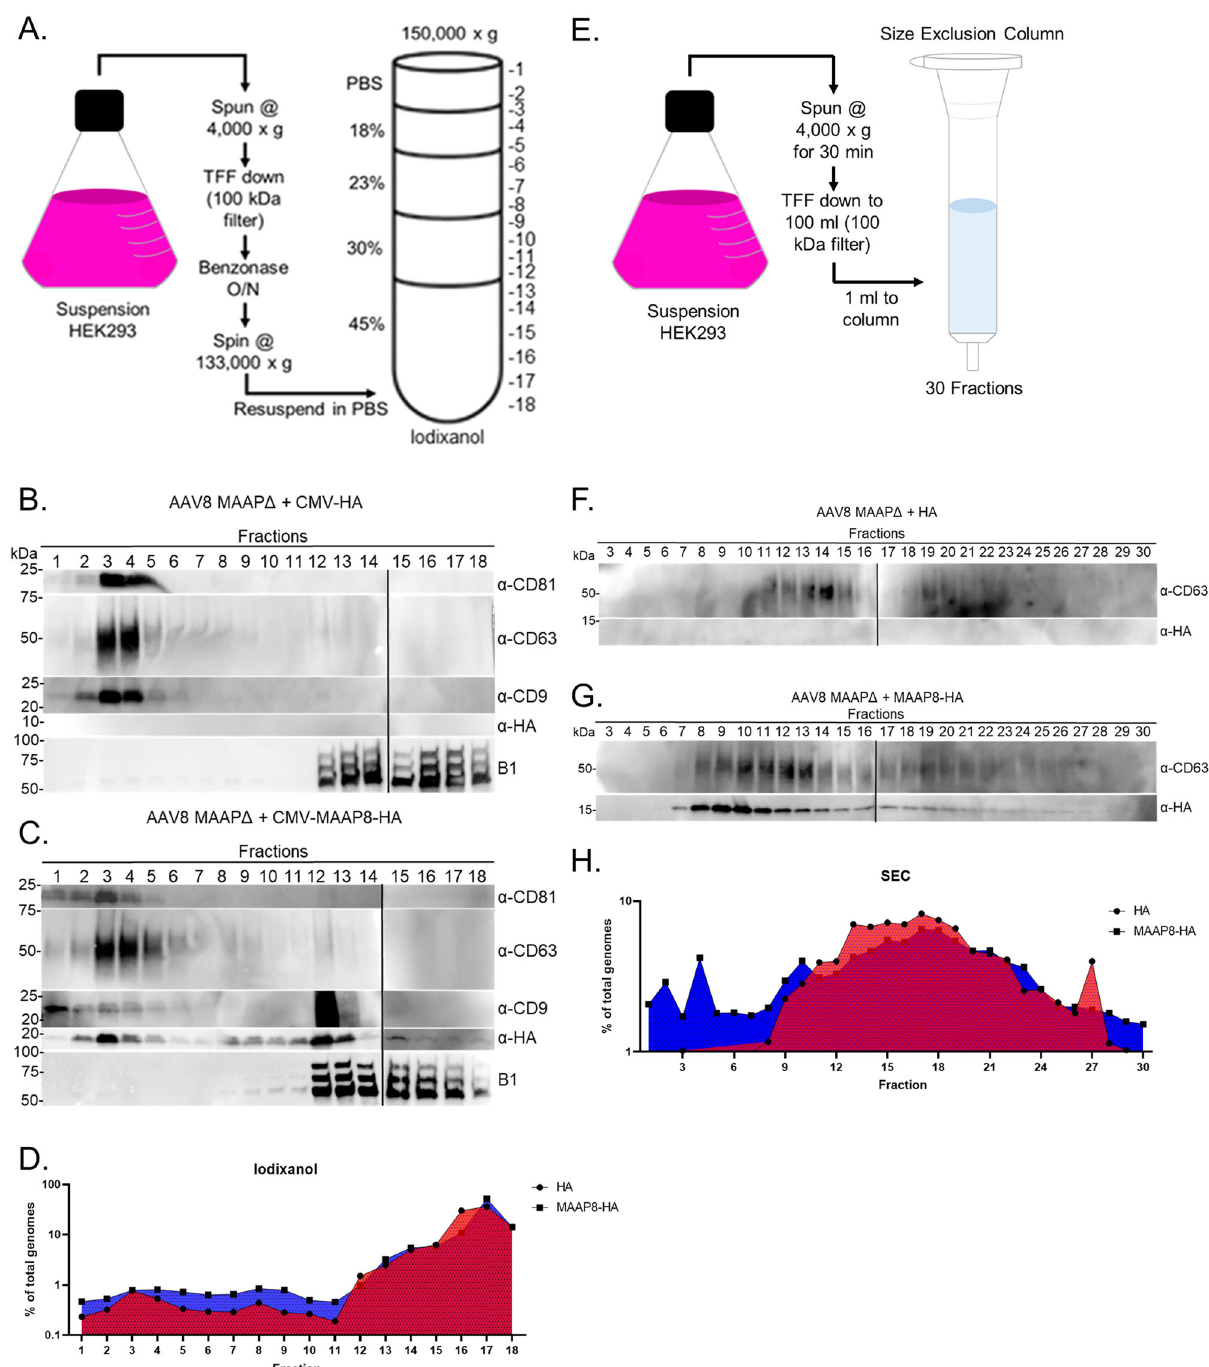
Fig. 5 MAAP promotes association of AAV with EVs. A Schematic of EV isolation by iodixanol density gradient from HEK293 suspension culture. B Immunoblots of iodixanol fractions from suspension cells producing recombinant MAAP8 Δ vector complemented in trans with CMV-HA and C CMV- MAAP8-HA. EVs, capsid and MAAP were analyzed from the media of HEK293 producing cells at day 3 post transfection. Capsid and MAAP proteins were analyzed by SDS-PAGE under reducing conditions while EV markers (CD81, CD63, CD9) were analyzed by SDS-PAGE under non-reducing conditions ( n = 2). D Graph displaying percent vector genome titer relative to total viral genomes for each fraction from iodixanol gradient puri fi ed MAAP8 Δ vector complemented in trans with CMV-HA and CMV-MAAP8-HA. E Schematic of EV isolation by size exclusion chromatography (SEC) from HEK293 suspension culture. F Immunoblots of SEC fractions from suspension cells producing recombinant MAAP8 Δ vector complemented in trans with CMV-HA and G CMV-MAAP8-HA. EVs and MAAP were analyzed from the media of HEK293 producing cells at day 3 post transfection. MAAP protein was analyzed by SDS-PAGE under reducing conditions while the EV marker CD63 was analyzed by SDS-PAGE under non-reducing conditions ( n = 2). H Graph displaying percent vector genome titer relative to total viral genomes for each fraction from SEC puri fi ed MAAP8 Δ vector complemented in trans with CMV-HA and CMV-MAAP8-HA.